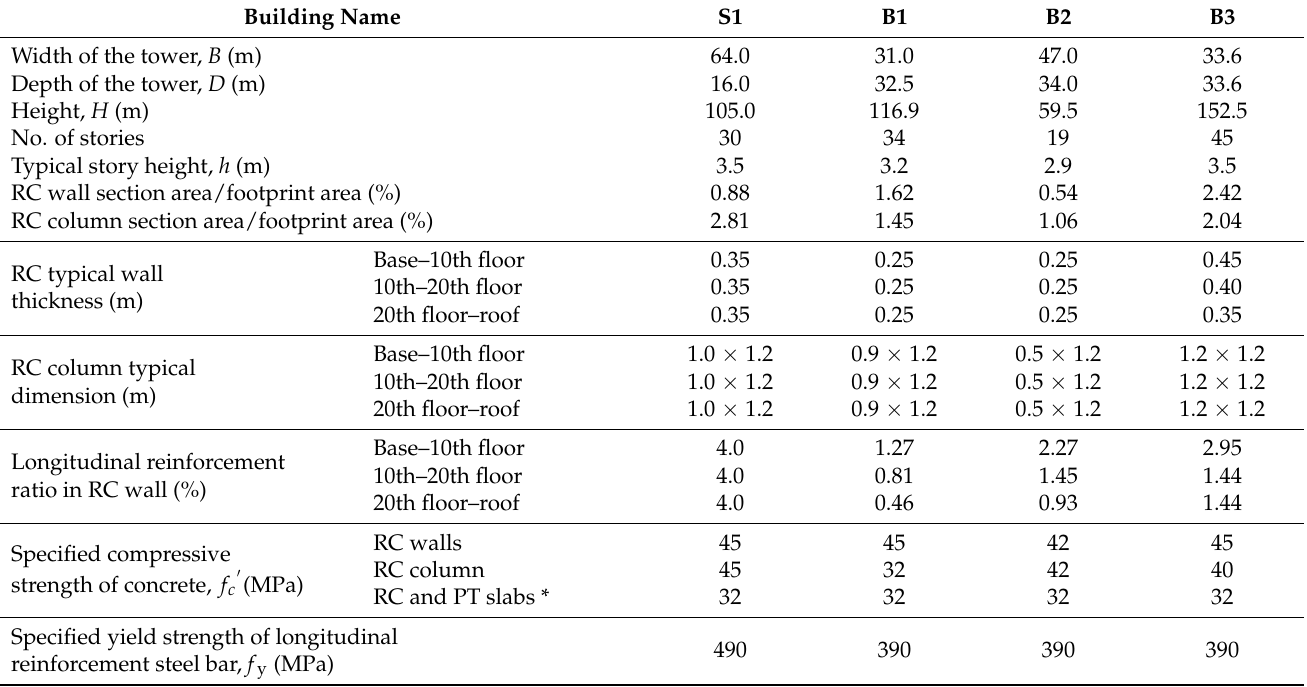
Table 1. Key properties and characteristics of four case study